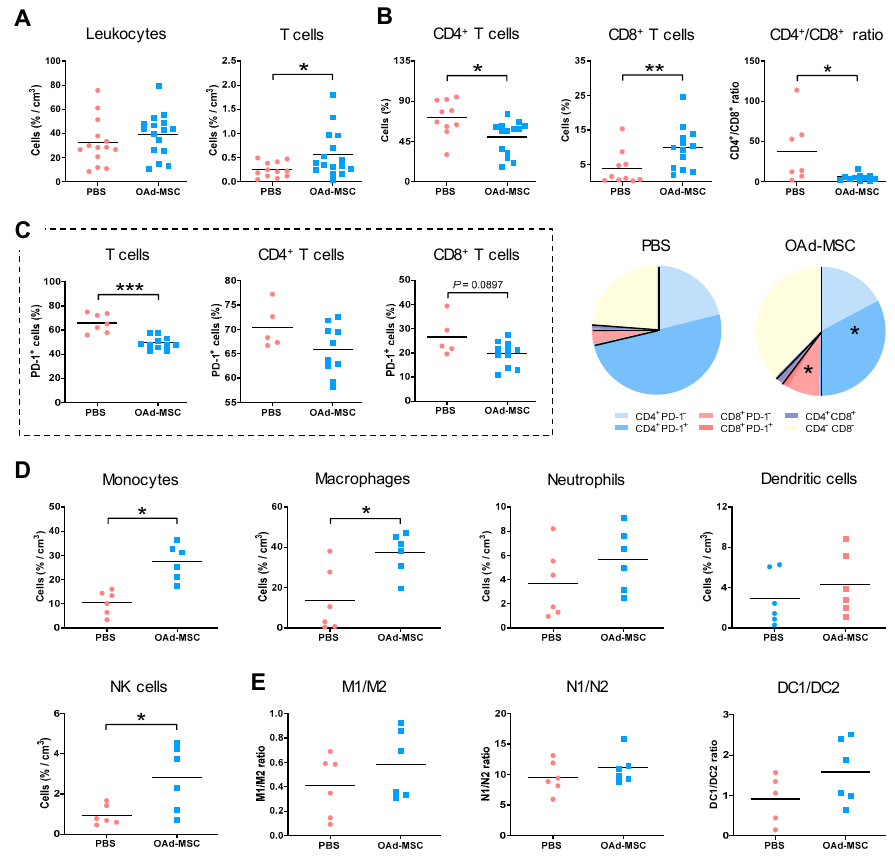
Figure 4. Tumor-infiltrating immune cells in renal adenocarcinoma. ( A ) Density of tumor-infiltrating lymphocytes (TILs) and leukocytes at end points, expressed as percentage per cm 3 of tumor. ( B ) Percentage of CD4 + and CD8 + T cell subsets from T cells, as well as CD4 + /CD8 + ratio ( n = 10–15). ( C ) Percentage of TIL, CD4 + , and CD8 + T cells expressing programmed cell death protein 1 (PD-1) ( n = 5–11). The pie chart shows percentages of CD4 + PD-1 − (blue), CD4 + PD-1 + (dark blue), CD8 + PD-1 − (red), CD8 + PD-1 + (dark red), CD4 + CD8 + (purple), and CD4 − CD8 − (yellow) T cell subsets from the TILs. ( D ) Density of tumor-infiltrating innate immune cells and natural killer (NK) cells ( n = 6). ( E ) Ratio of pro-inflammatory (1) and anti-inflammatory (2) status of macrophages, neutrophils, and dendritic cells ( n = 5–6). (Mann–Whitney U test) * p < 0.05, ** p < 0.01, *** p <